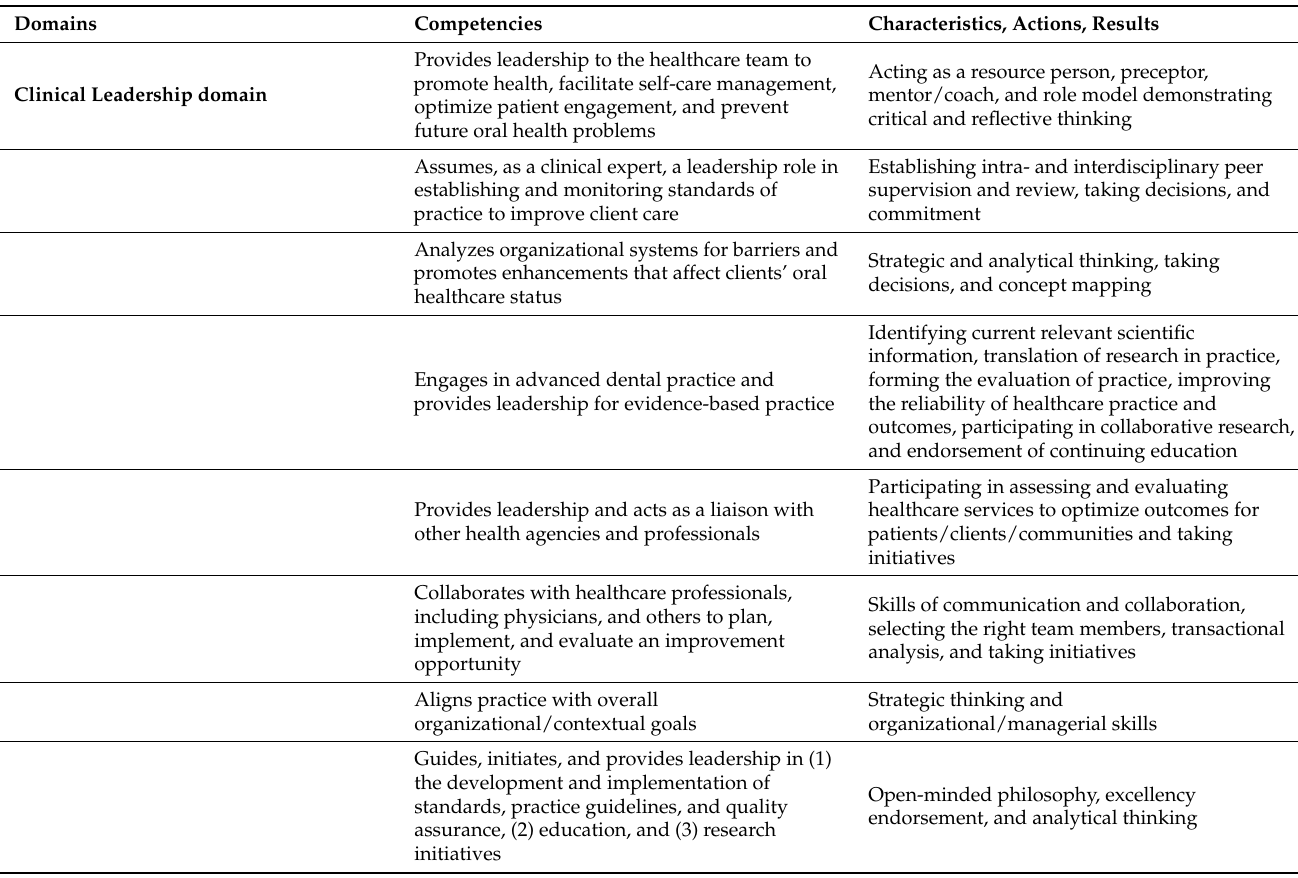
Table 1. Domains, competencies, and characteristics of leadership. Domains Competencies Characteristics, Actions, Results Clinical Leadership